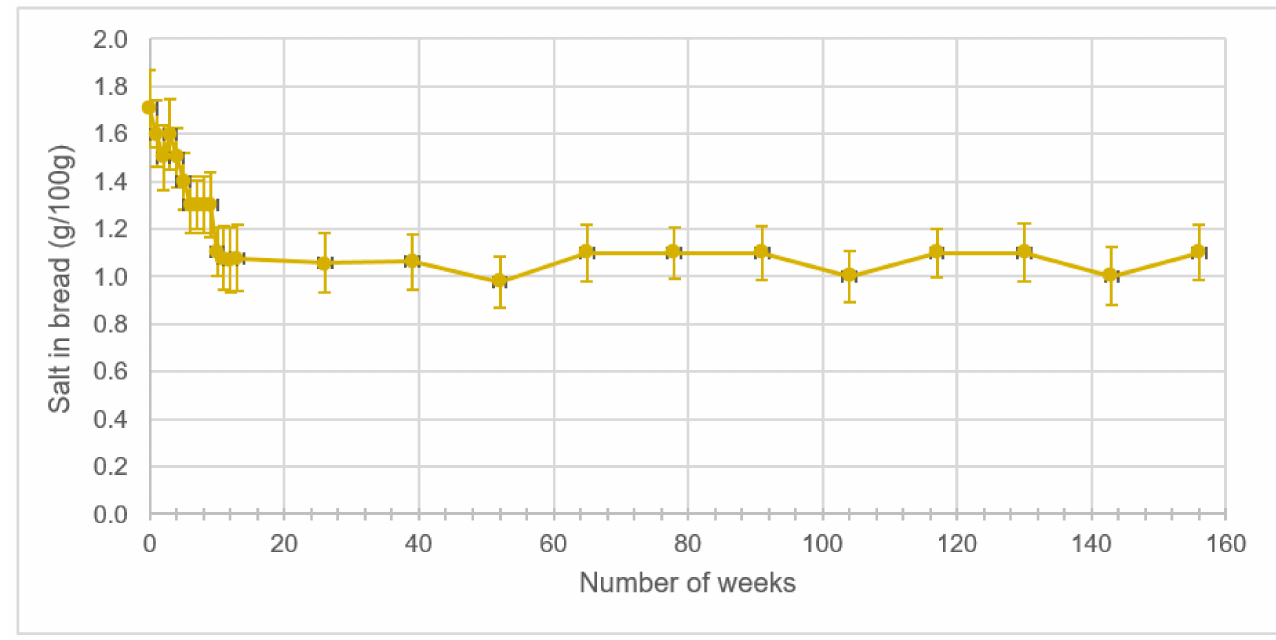
Figure 2. Mean levels and standard deviations of salt in bread collected from Bizerte city after application of the salt reduction